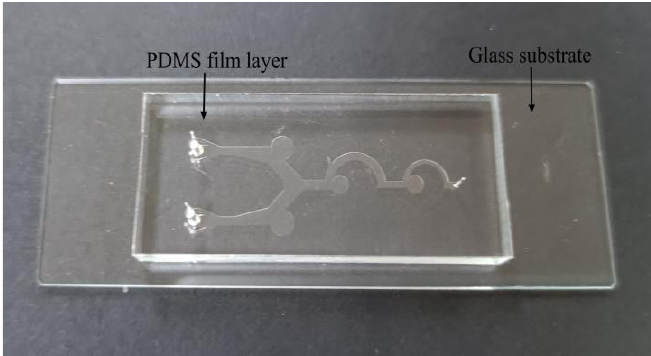
Figure 2. Real object of microfluidic chip.